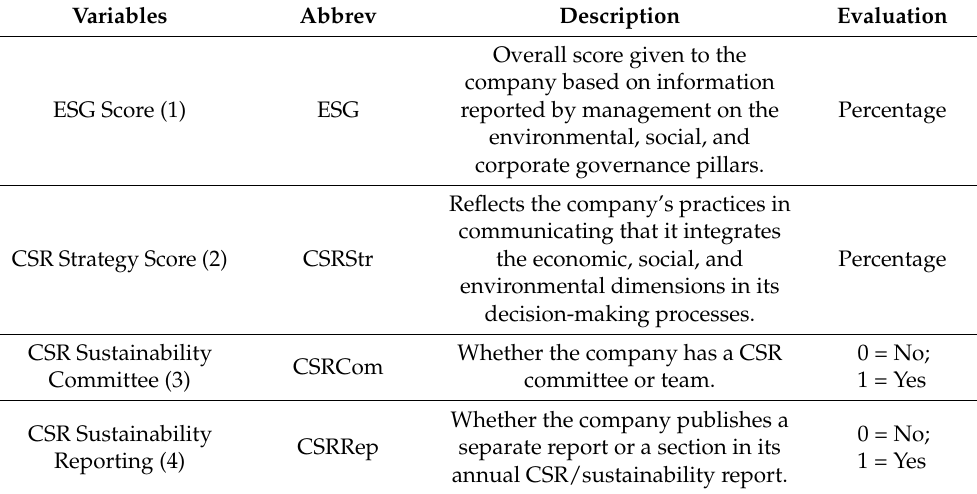
Table 3. Description of CSR proxies.